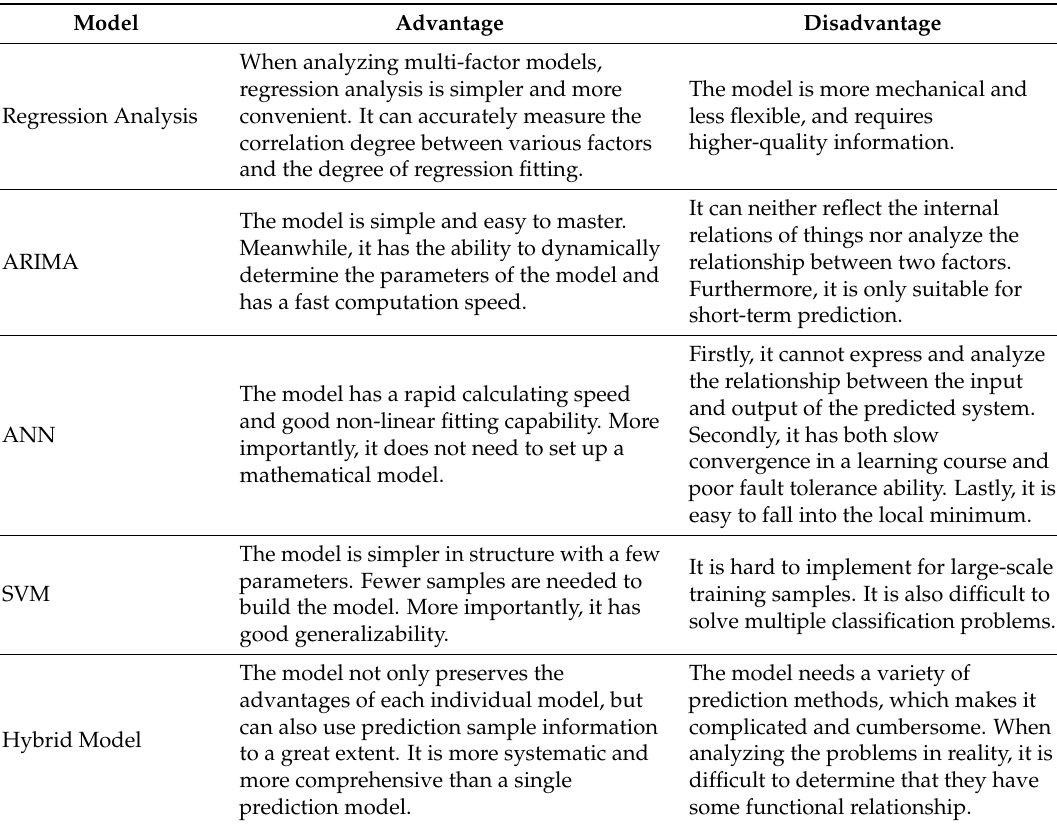
Table 1. The features of several common